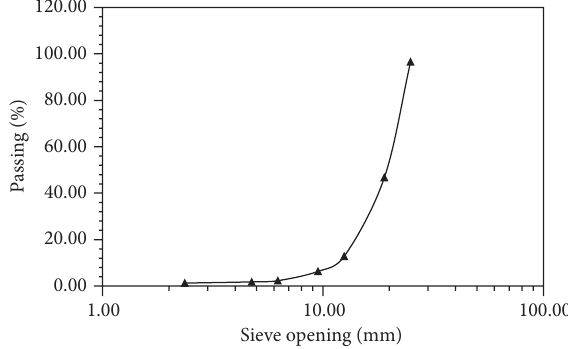
Figure 3: Gradation curve of coarse aggregate